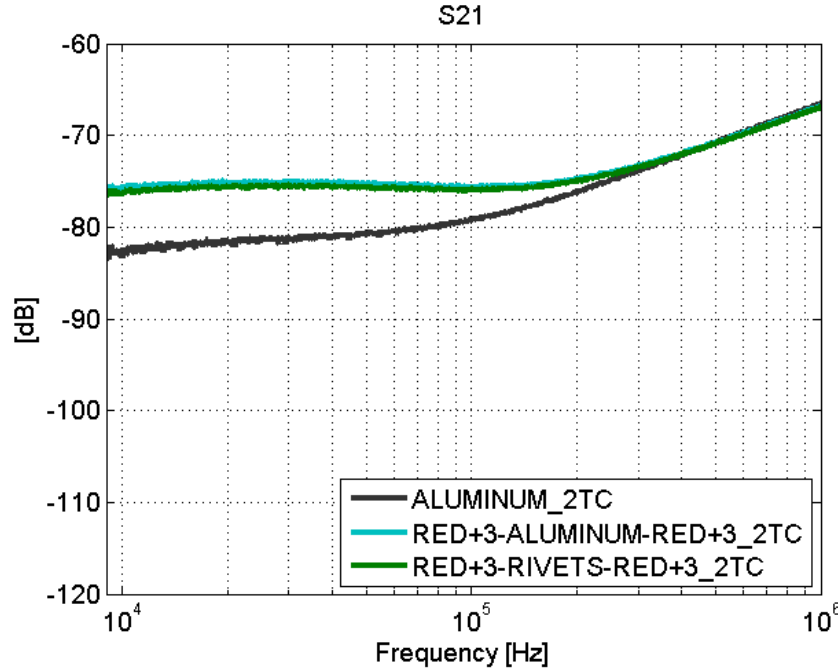
Figure 17. Surface current test: S 21 . Fastener joints. Line